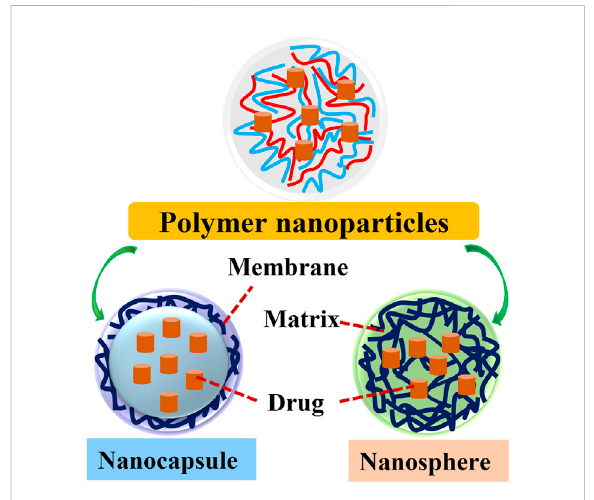
FIGURE 1 Thestructureoftwotypesofpolymernanoparticles.Polymer NPs are classi fi ed into nanocapsules and nanospheres. Polymeric nanosphere is a matrix type, insoluble solid-colloidal particle in which drugs are distributed throughout the chemical compound matrix. Polymeric nanocapsule is a colloidal-vesicular system where the drug is con fi ned to a cavity surrounded by a distinctive compound